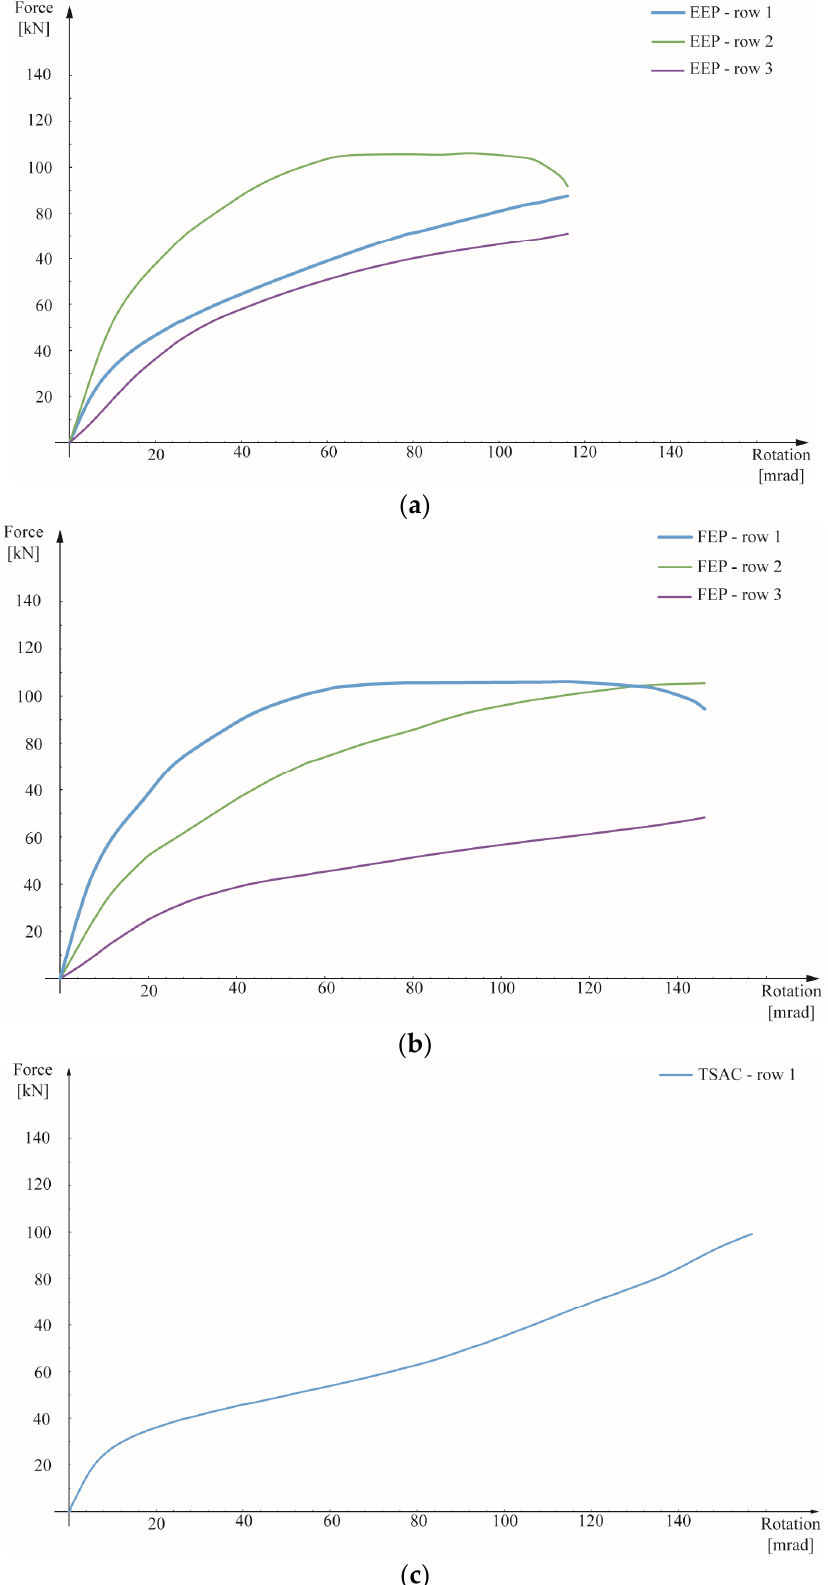
Figure 11. Bolt forces vs. joint rotation curves. ( a ) Extended End-Plate (EEP), ( b ) Flush End-Plate (FEP), ( c ) Top-and-Seat Angle Cleat (TSAC).